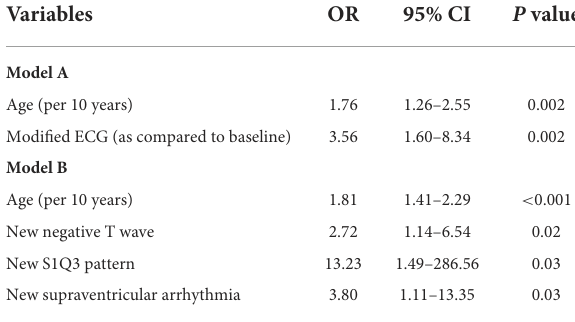
TABLE 4 New ECG abnormalities observed during hospitalization, n = 169.